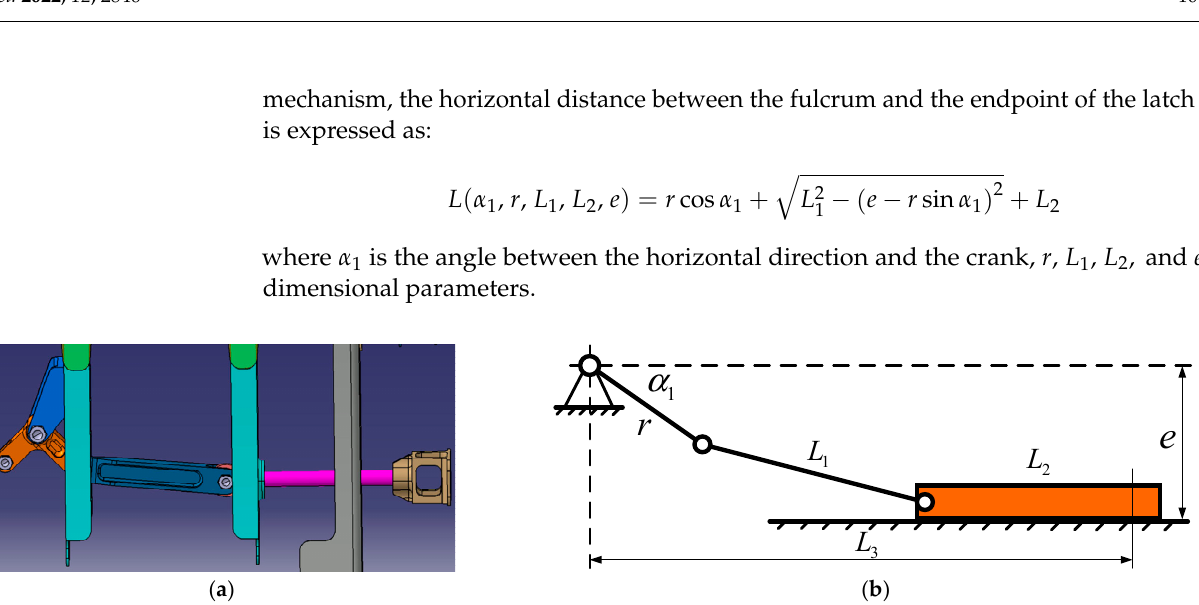
Table 1. Distribution parameters of input factors.